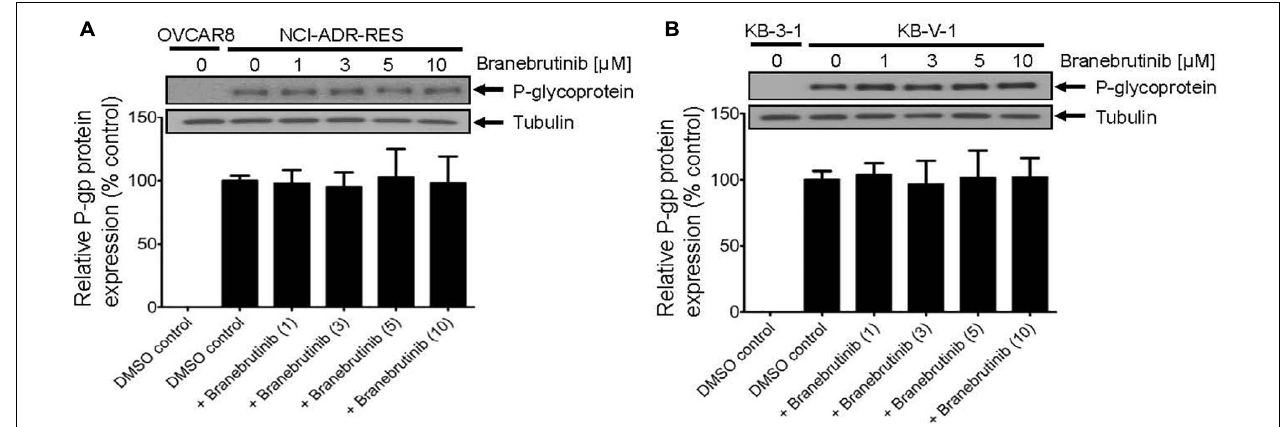
FIGURE 3 | Branebrutinib has no significant effect on the P-glycoprotein (P-gp) protein levels after 72 h exposure. The P-gp-overexpressing (A) NCI-ADR-RES and (B) KB-V-1 cancer cells were treated with DMSO (vehicle control) or branebrutinib at 1, 3, 5, or 10 µ M for 72 h and processed for immunoblotting with indicated antibodies as described in Materials and methods. Representative Western blots (upper panel) and the corresponding quantification (lower panel) of P-gp are shown. α -Tubulin was used as an internal loading control. Values are presented as mean ± SD. Calculated from at least three independent experiments.